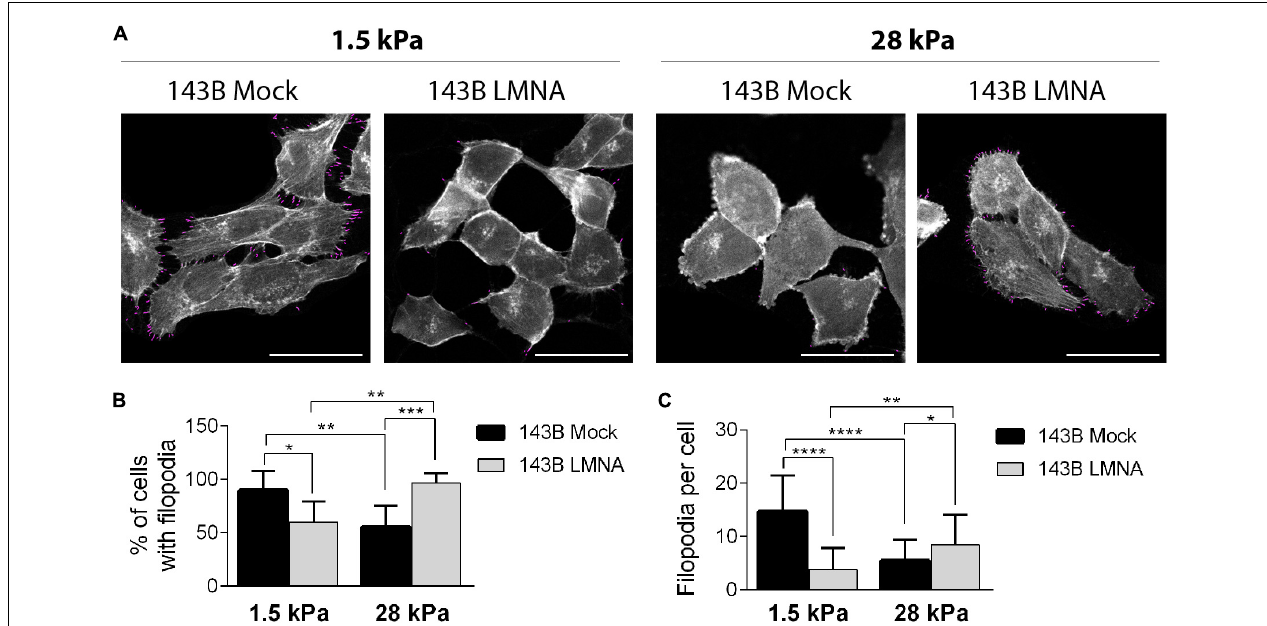
FIGURE 4 | Evaluation of 143B cell adhesion on the two different PDMS substrates. (A) Representative pictures obtained by ImageJ Filoquant analysis performed on 143B Mock and 143B LMNA cells stained with phalloidin (pseudo-colored in white) and cultured on PDMS substrates with a 1.5 and 28 kPa elasticity Filopodia resulted by Filoquant analysis are shown in purple staining. Bar: 40 µ m, n = 50. Relative quantification of% of cell with filopodia (B) and filopodia density (C) derived from ImageJ Filoquant analysis performed on 143B Mock and 143B LMN-A cells cultured on PDMS substrates with a 1.5 and 28 kPa elasticity. * p < 0.05; ** p < 0.01; *** p < 0.005; **** p < 0.001.